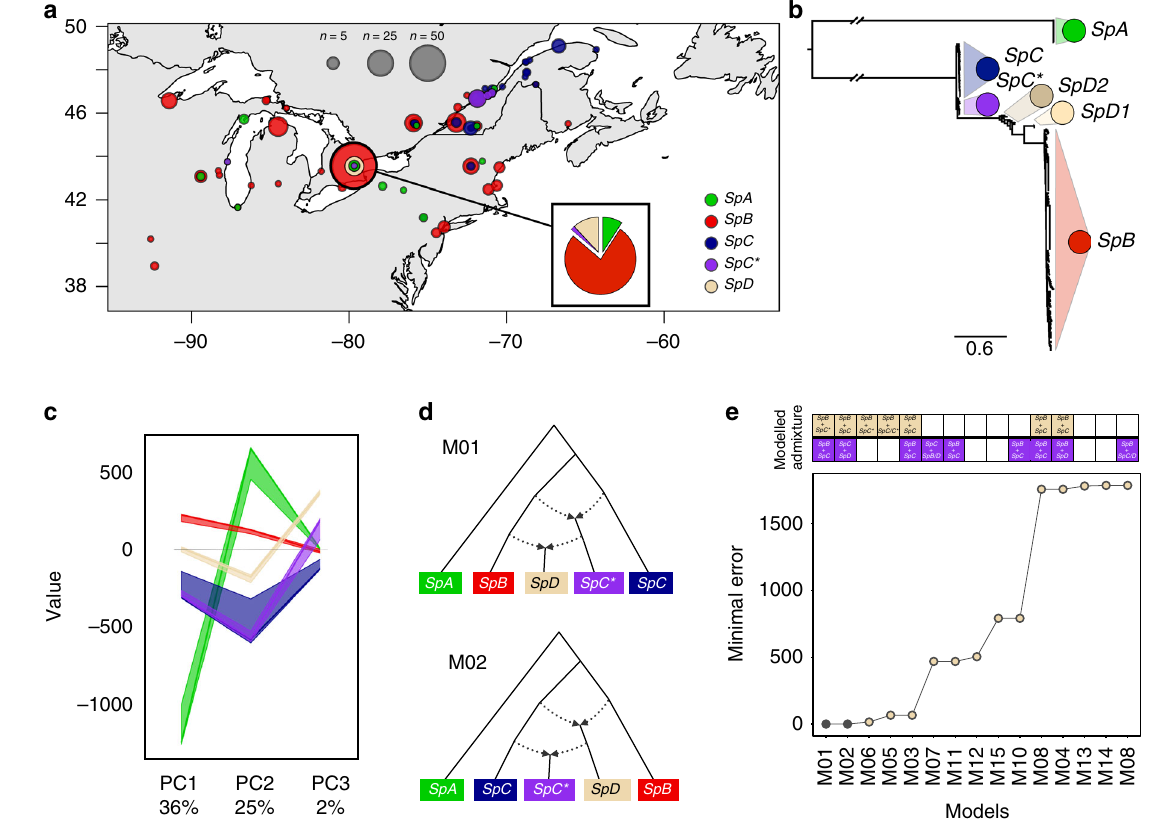
Fig. 1 Population structure of Saccharomyces paradoxus in North America. a Sampling locations (circles) of 316 whole-genome sequenced strains from fi ve distinct groups: SpA, SpB, SpC, SpC * , and SpD 15 – 17 . The map was drawn with R v3.3.3 82 using the package maps (version 3.3.0). Detailed strain information can be found in Supplementary Data 1. b Genetic relationship among isolates from a maximum likelihood phylogenetic tree built from 25,280 variable positions. SpD splits into the two sub-clades SpD1 and SpD2 as previously suggested by Hénault et al. 17 . c Grouping of strains by principal component analysis showing the relationship among lineages. PC1 to PC3 separate SpA, SpB, SpC, SpC *, and SpD as independent genetic clusters (For color code, see Fig. 1a). The spread of strains (median and the 20th to 80th percentile range) in each PC (x-axis) is shown. d The two models (M01, M02) from the f4 statistics explain admixed ancestry of SpC * and SpD . Dotted arrows indicate admixture events. e Ranking of the 15 models based on their fi t to the data. Filled squares on the top indicate if the models assume admixed ancestry of SpD and SpC *. The fi ve best models indicate hybrid origin of SpD . The two best models matching all f4 statistics ( fi lled dots) suggest a hybrid origin for SpD resulting from a cross between SpB and the hybrid SpC * (model M01), or hybrid origin of SpD resulting from a cross between SpB and SpC , occurring before the origin of a SpC * hybrid (model